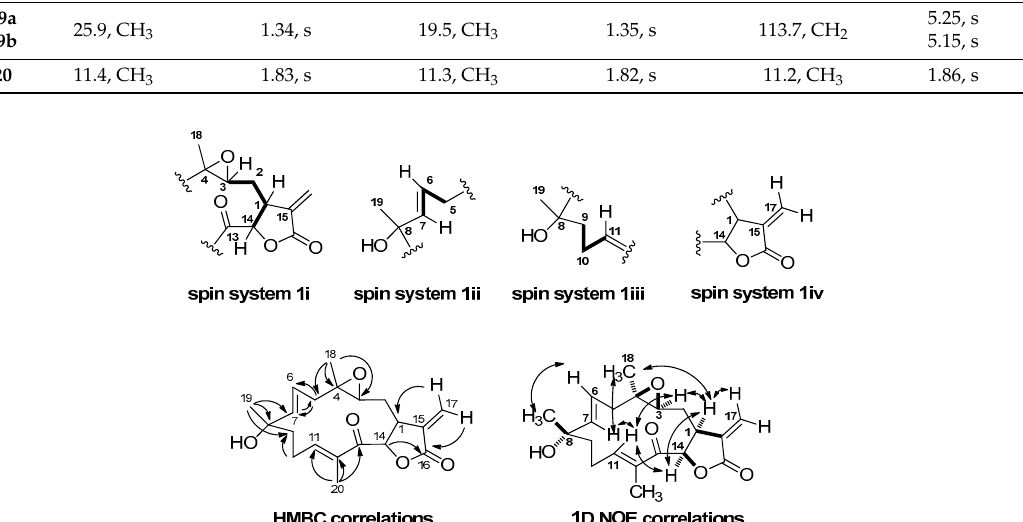
Figure 2. Correlation spectroscopy (COSY), heteronuclear multiple bond correlation (HMBC) and selected 1D nuclear Overhauser effect correlations for compound 1 .